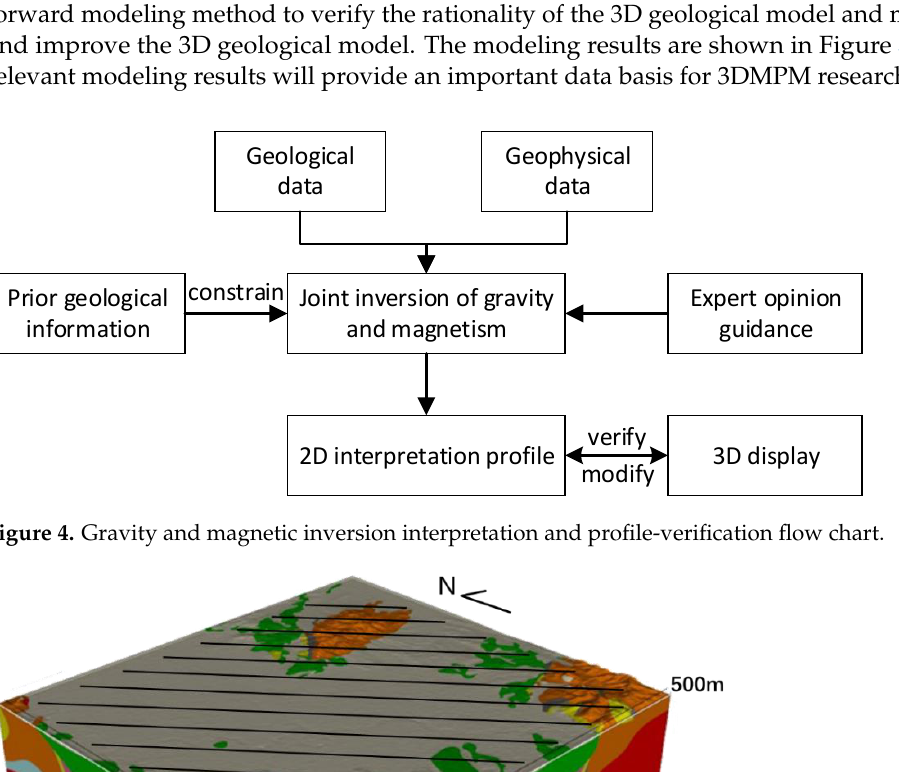
6 of 14 Figure 3. Geological map of Magushan Cu-Mo deposit. (Modified from Bian. [19], Ye. [43], and Hong et al. [44]). 3.2. Database In previous studies [43], 2D geological profiles covering the whole area were first established in the Magushan ore field, and these geological profiles were interpreted us- ing the gravity and magnetic joint inversion method. Combined with prior geological con- straints and based on the collected regional physical property data, the joint inversion of gravity and magnetic fields finally obtains a 2D profile that can show the thickness, depth, extension direction, hidden rock mass shape, and geological structure of each layer in the region. After the gravity and magnetic joint inversion, a set of verification methods based on the 3D visualization function of the profile is used to verify the rationality of the inter- preted profile, and the unreasonable parts in the profile are modified. The whole process of gravity and magnetic inversion interpretation and profile verification and modification is shown in Figure 4. Then, based on the two-dimensional geological profile, geological